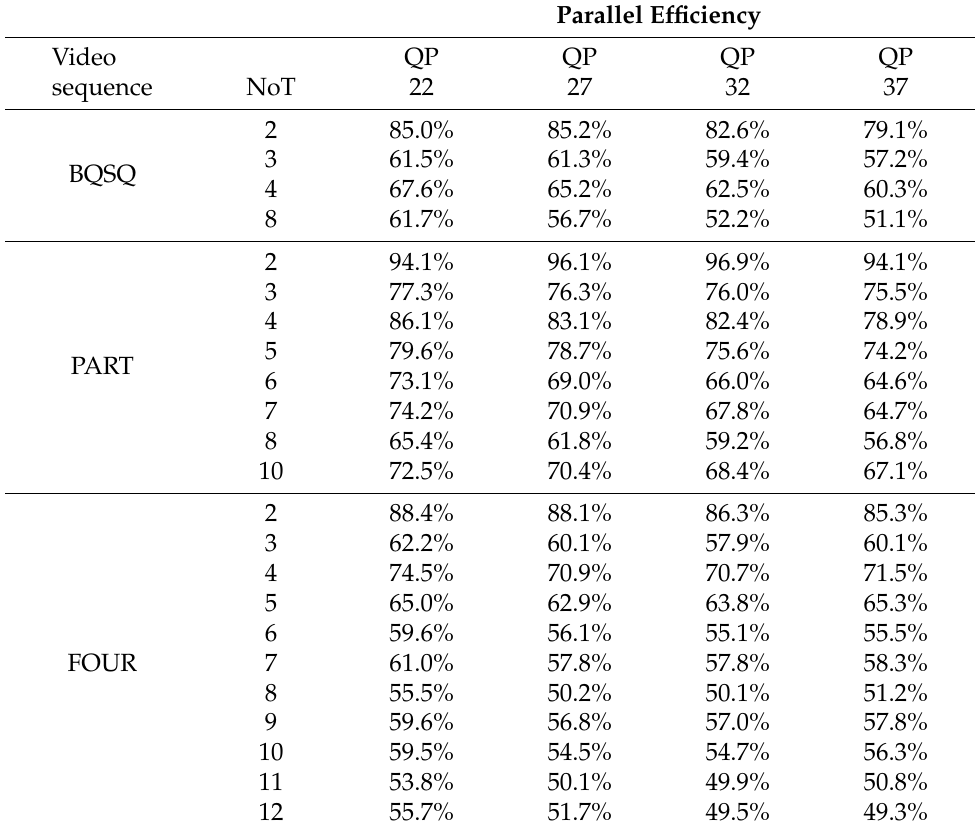
Table 12. Parallel efficiency for Algorithm